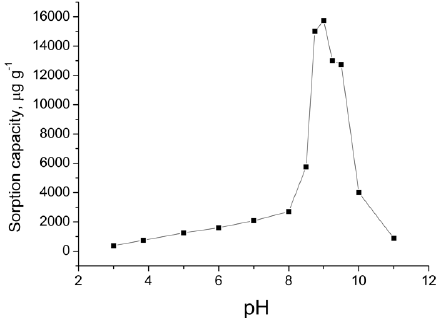
Figure 1. Dependence of the sorption capacity of clinoptilolite towards praseodymium(III) on the pH value of the aqueous solution (concentration of Pr(III): 1.0 μ g·mL − 1 ).